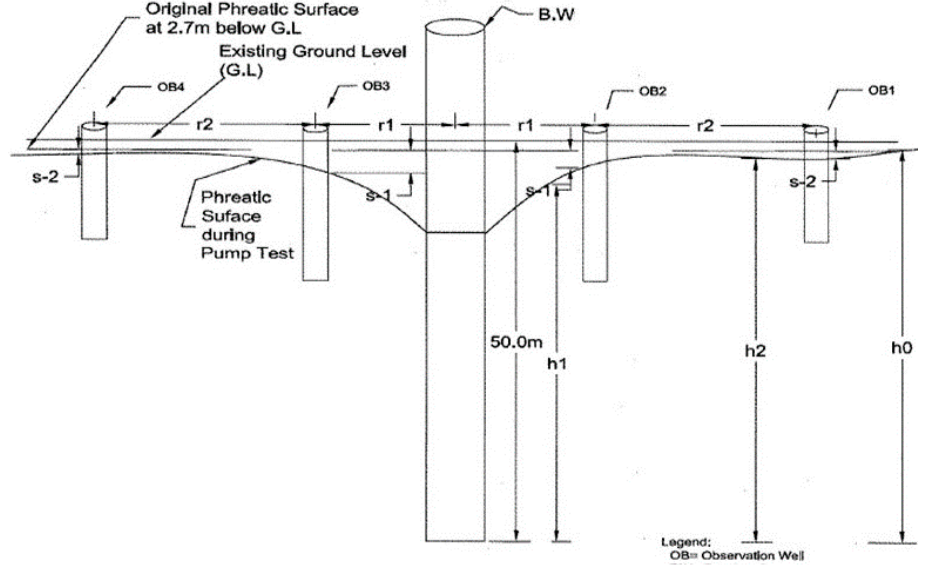
Figure 3. Schematic diagram of the beach well and the observation wells.